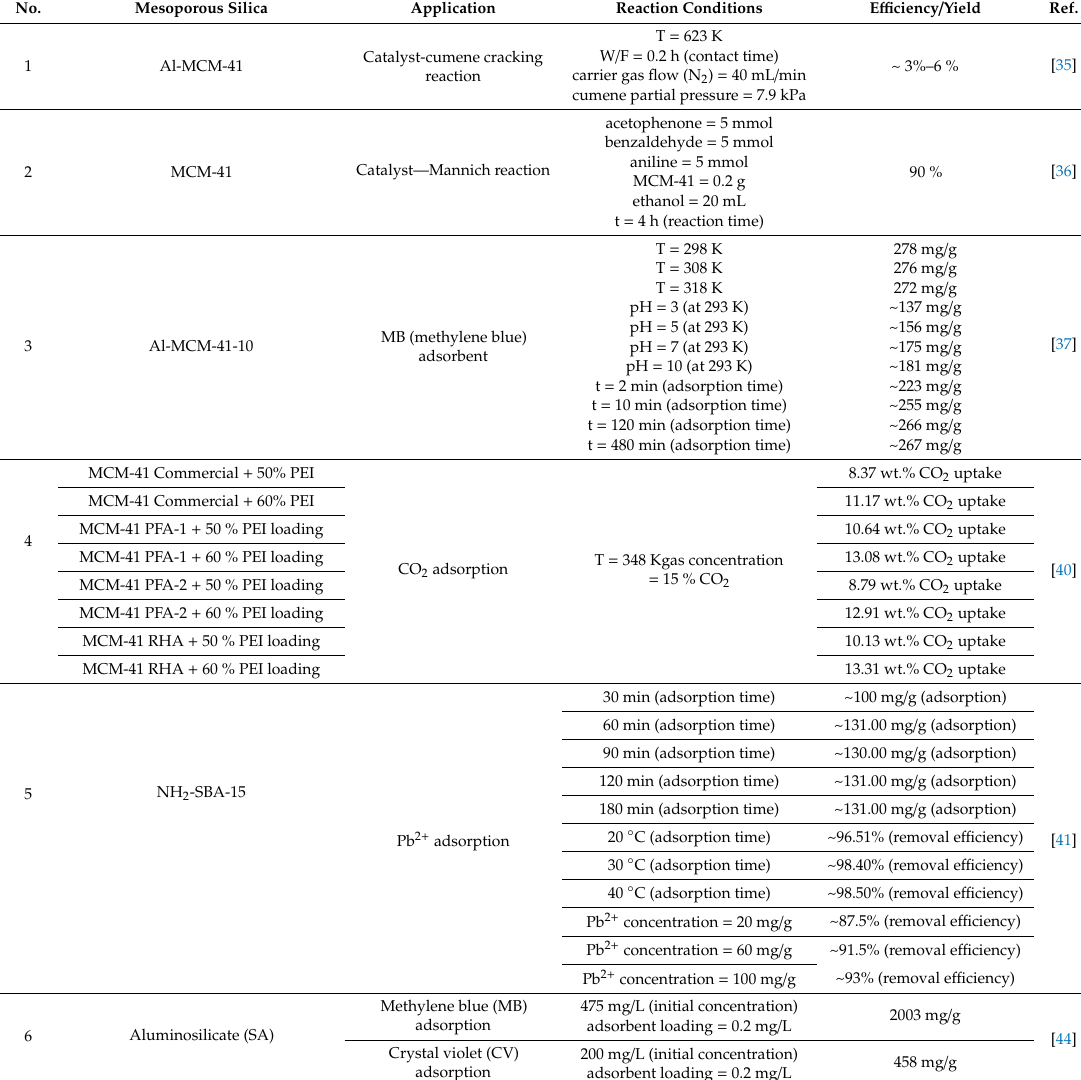
Table 2. Applications of the synthesized mesoporous